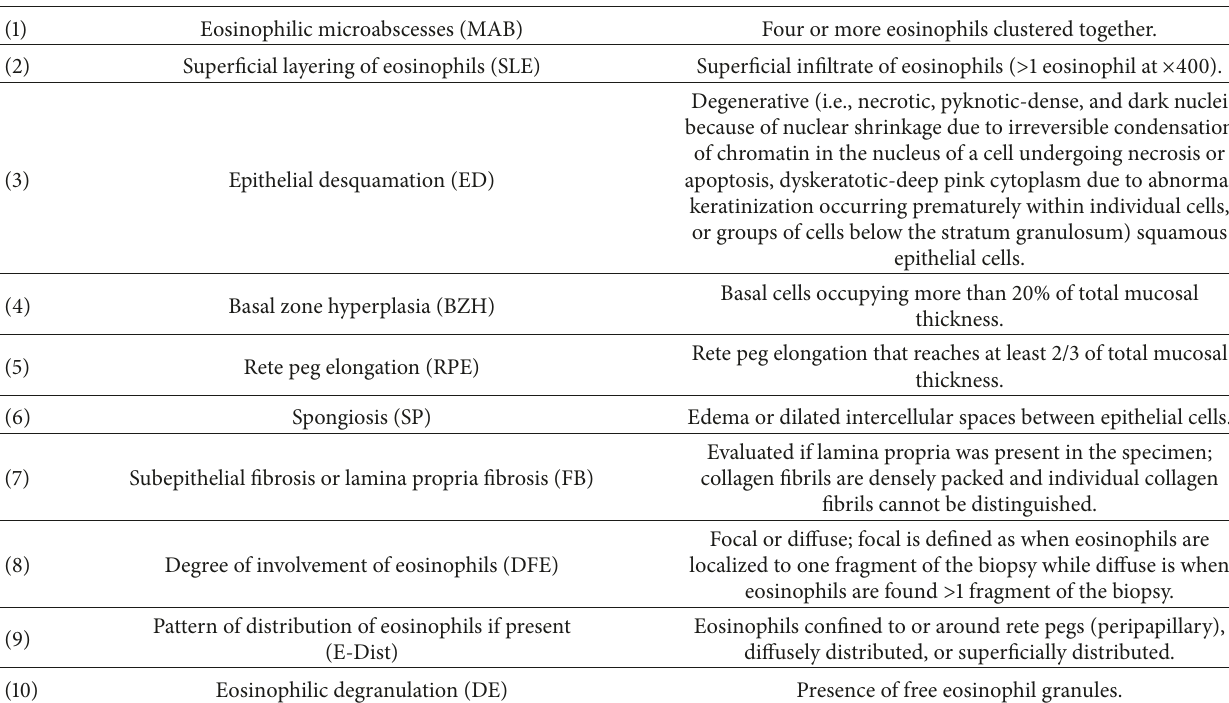
Table 3: Histological criteria evaluating the degree/stage of eosinophil-rich